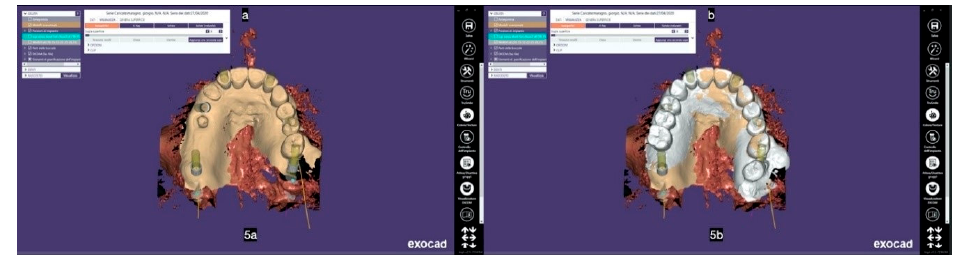
Figure 3. The superimposition of STL files from both intraoral ( a ) and waxed-up plaster model scanning ( b ) onto the DICOM files from the CBCT.